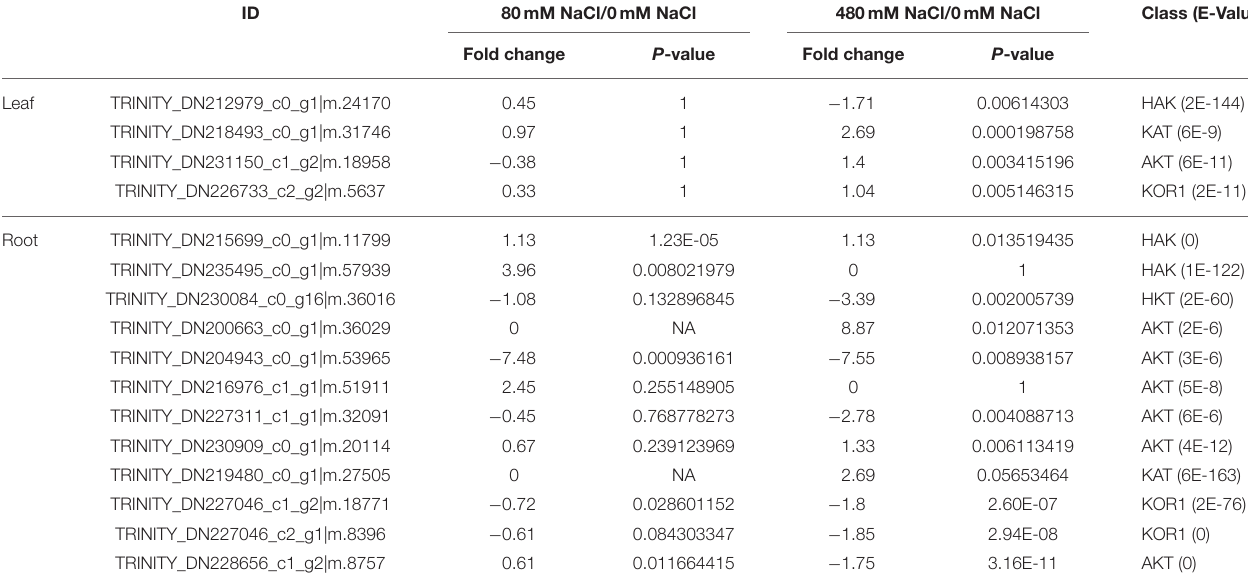
TABLE 4 | Fold changes of differentially expressed K + transporter genes under salinity stresses in the leaves and roots of K. sieversiana . ID